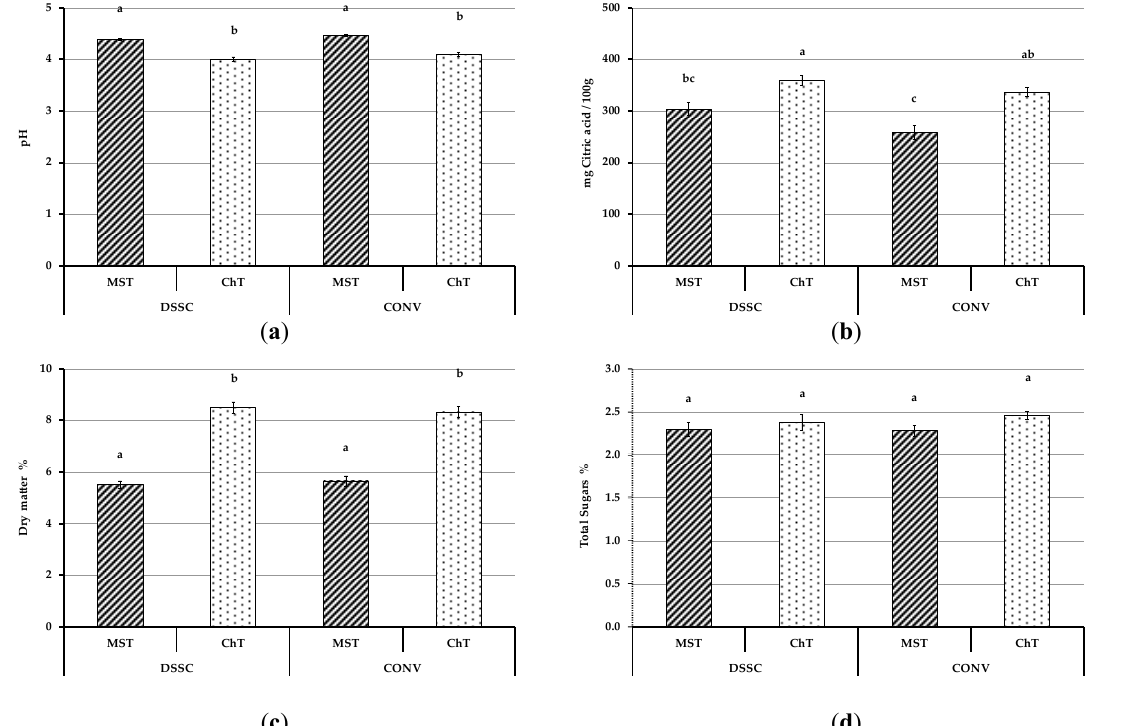
Figure 6. Physical parameters of fruits, independent of inflorescence, of the two tomato hybrids [MST (medium-sized) and ChT (cherry)] in the two greenhouses [DSSC (Dye-Sensitized Solar Cell) and CONV (Conventional)]: ( a ) pH; ( b ) citric acid %; ( c ) dry matter %; and ( d ) total sugars %. Bars with different letters were significantly different by LSD at P ≤ 0.05.